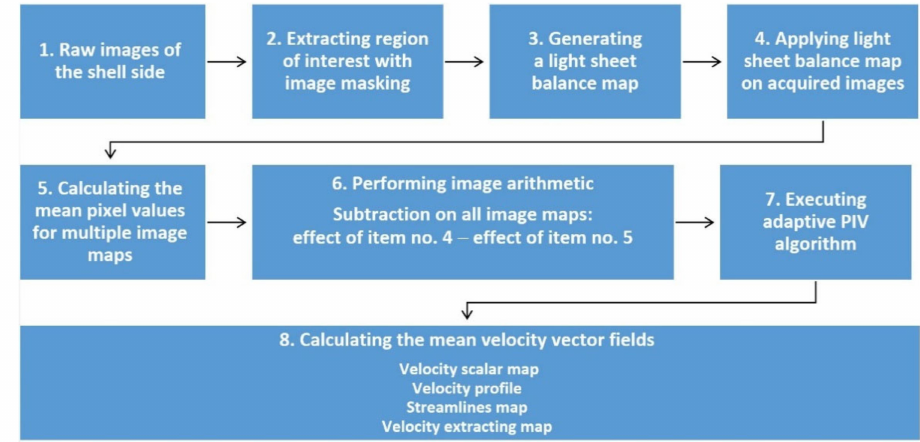
Figure 3. Applied PIV methodology.